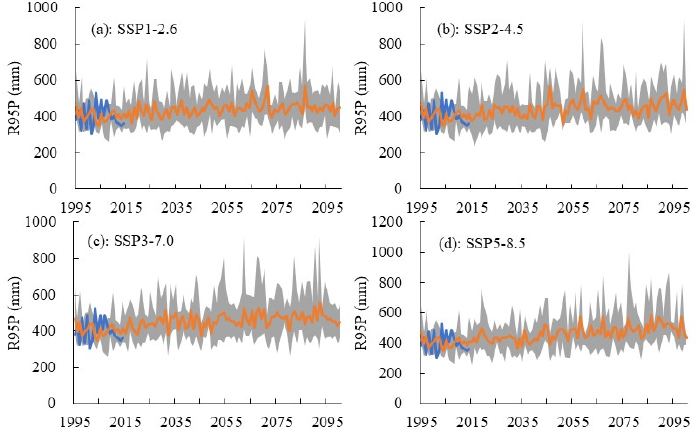
Figure 4. Historical variation and projection trend of R95P under SSPs scenarios (a to d represent